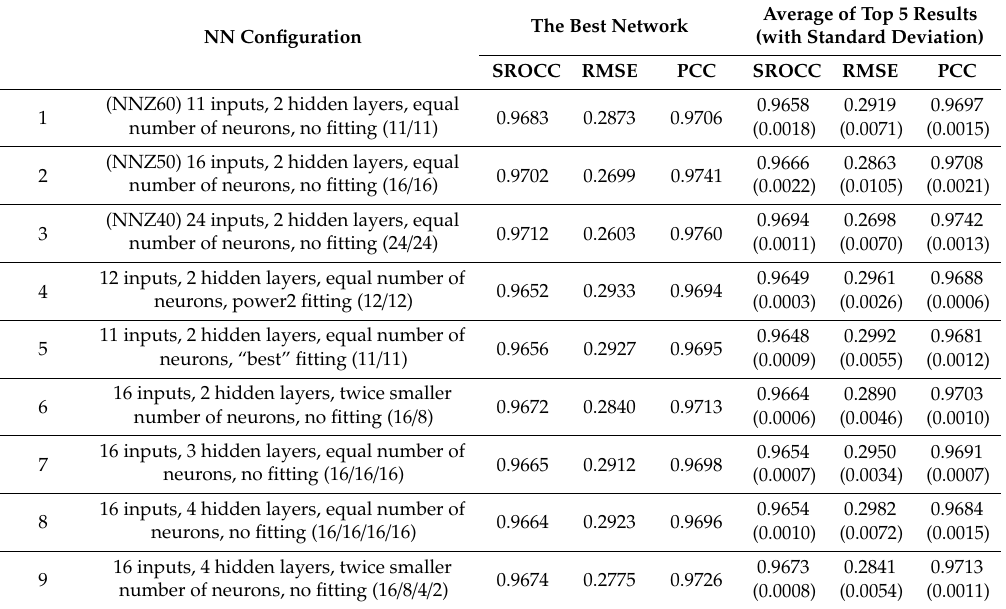
Table 6. Performance characteristics of designed NN-based combined quality